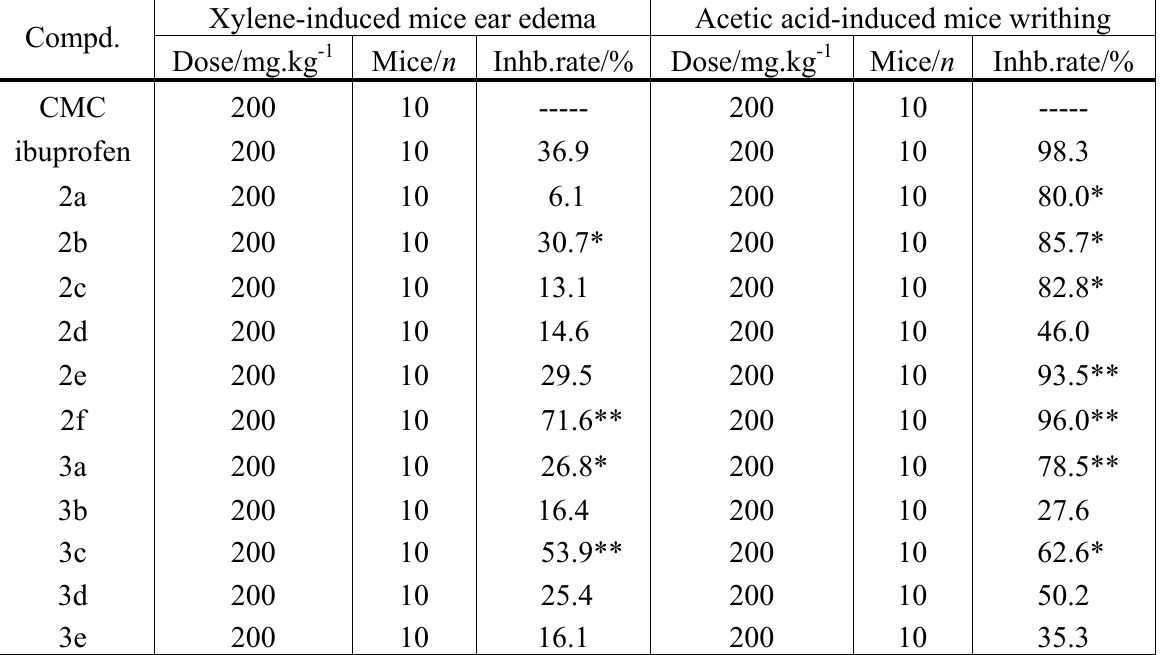
Table 1. Inhibition on xylene-induced mice ear edema and acetic acid-induced mice writhing Xylene-induced mice ear edema Acetic acid-induced mice writhing